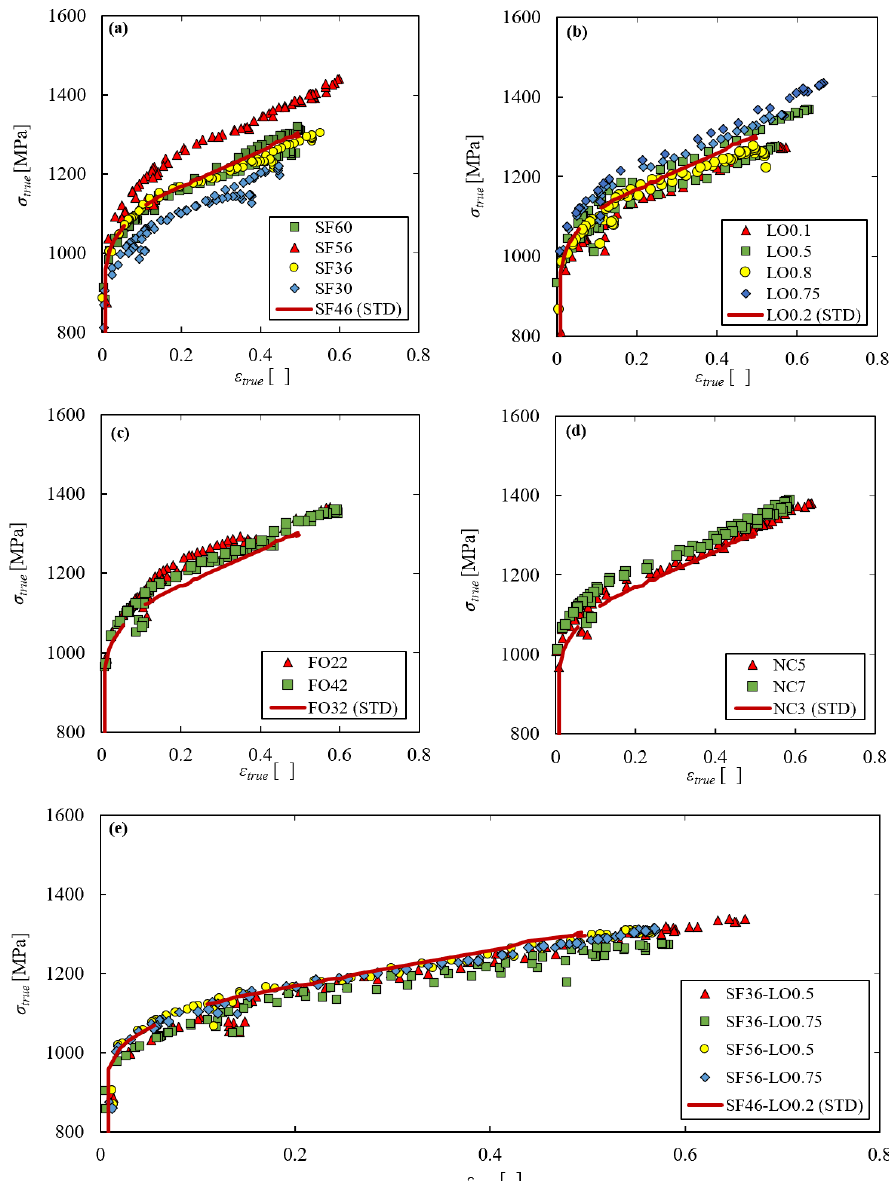
Figure 3. Static experimental series: comparison between the true stress–strain curves obtained with the standard EBM parameter set (solid line) and with the variated ones (scattered lines) changing the speed function ( a ), line offset ( b ), focus offset ( c ), number of contours ( d ) and speed function and line offset ( e